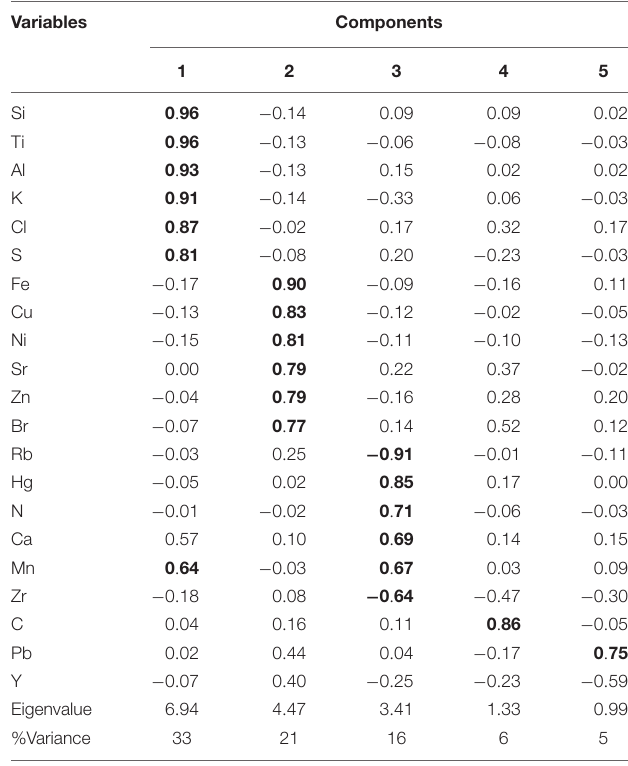
TABLE 1 | Factor loadings for the five significant components extracted by PCA from Congo Basin sediment